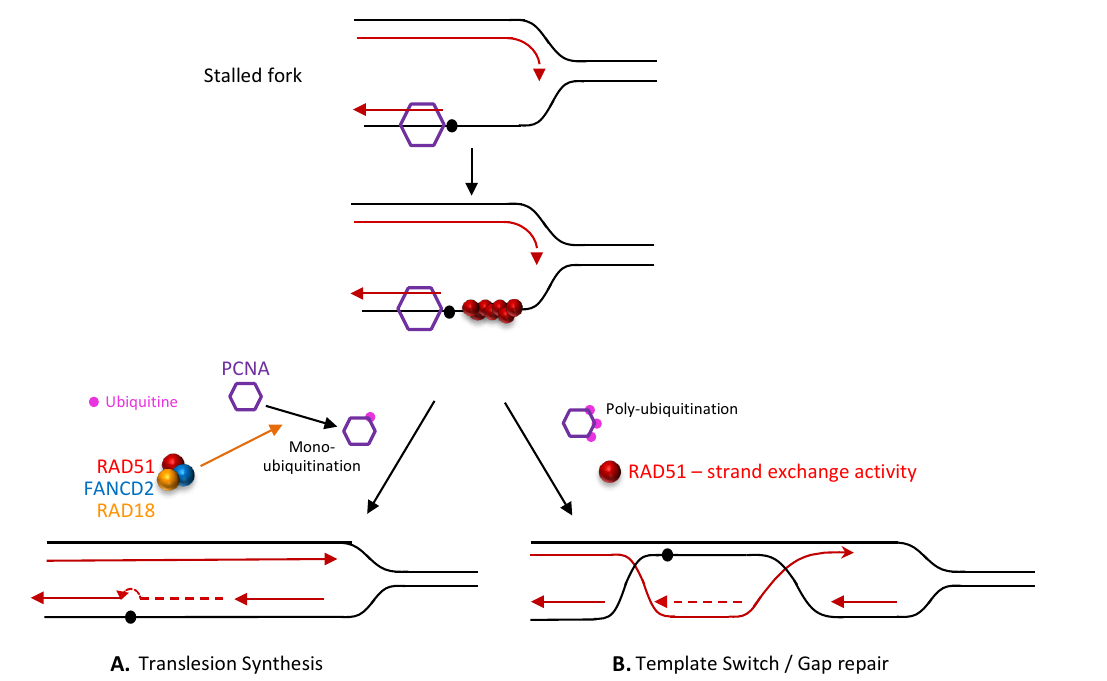
Figure 4. RAD51 and post-replicative repair. The parental strands are shown in black and the nascent strands are shown in red. Damage to the DNA matrix (black dot) can block the progression of the replication (red arrows), generating a single-stranded sequence. RAD51/FANCD2/RAD18 foster the mono-ubiquitination (pink dot) of PCNA (purple hexagon). ( A ). The mono-ubiquitination of PCNA favors DNA synthesis (red dotted line) through the damage using specialized TLS polymerases (TLS: translesion). ( B ). Poly-ubiquitination of PCNA favors the RAD51-mediated strand invasion of the sister chromatid (TS: template switching) allowing to initiate DNA synthesis (dotted line). TS is not initiated by a 3′-double-stranded end but by an ssDNA gap. The RAD51 strand exchange activity is involved in this mechanism and a newly synthesized strand serves as a replication template for the blocked strand.